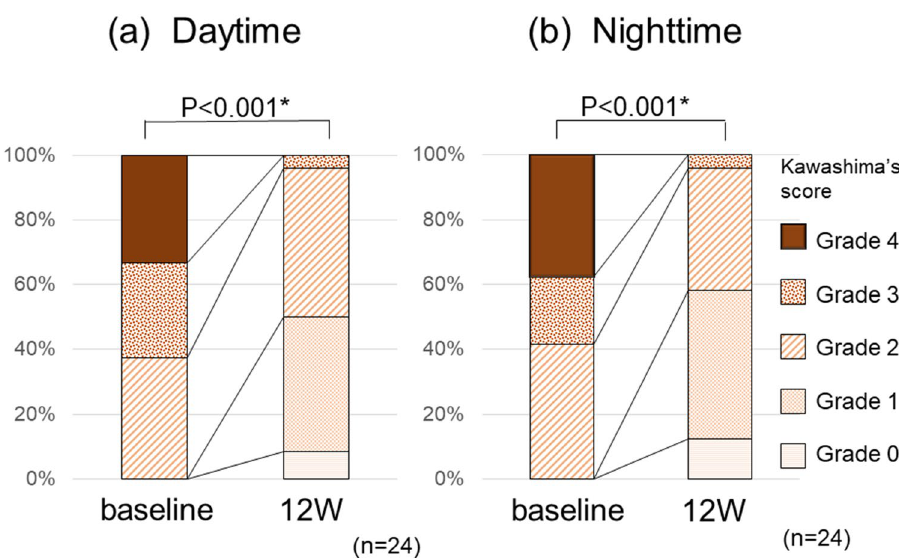
Figure 3. Kawashima’s score significantly decreased 12 weeks after administration of nalfurafine when compared with baseline scores during ( a ) daytime ( P < 0.001) and ( b ) nighttime ( P <